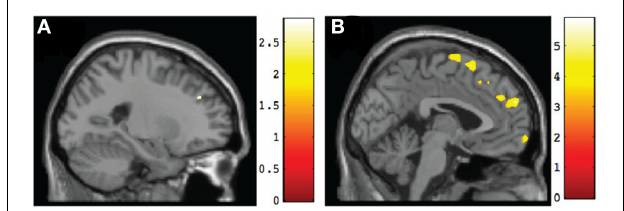
FIGURE 4 | Sagittal views of regions involving significant differences in gray matter volume at post-intervention. (A) TX vs. DTC group, left superior frontal gyrus (BA9) [ − 23, 38, 32], p < 0 . 005, uncorrected; (B) CT vs. TX group, left superior frontal gyrus (BA9) [ − 2, 58, 27], p < 0 . 001,